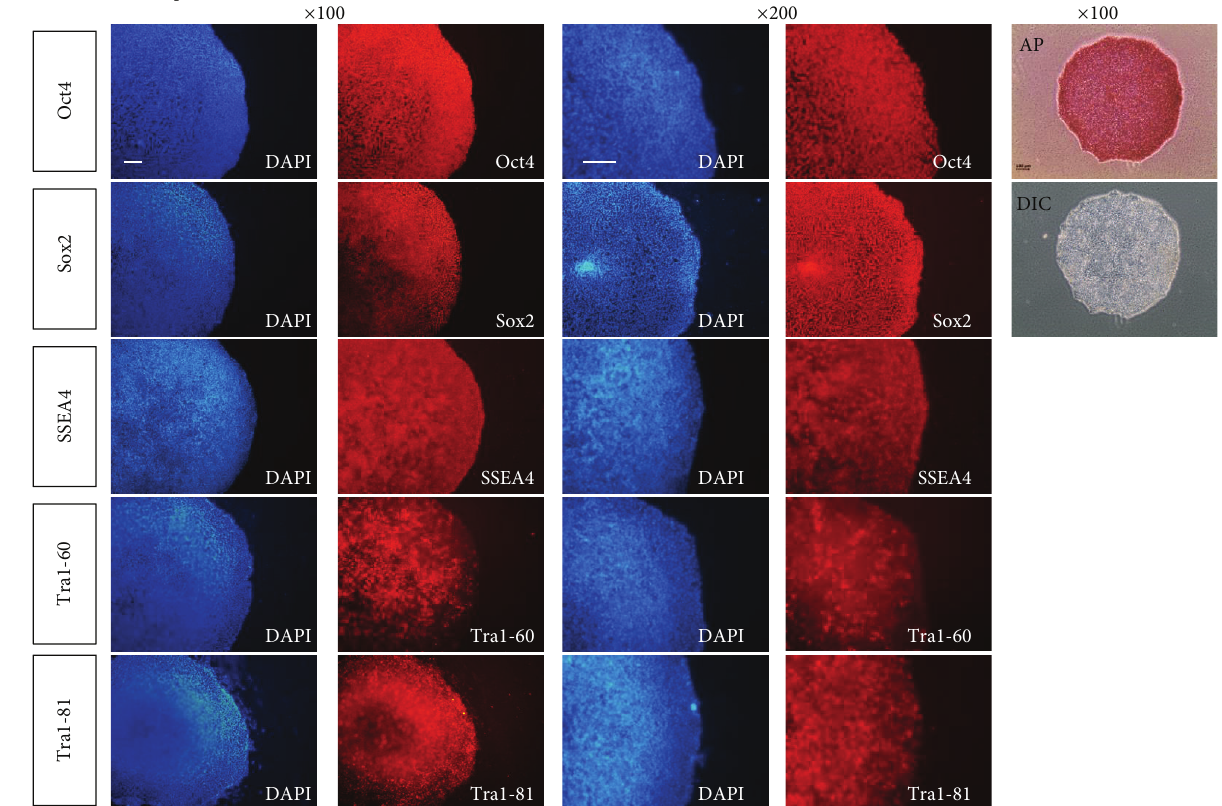
Figure 2: Immunostaining of the iPS cells for several pluripotent cell markers. The mRNA-iPSCs generated and cultured for 15 passages in our xeno-free/feeder-free hPSC system positively immunostained for the pluripotent cell markers Oct4, Sox2, SSEA4, Tra1-60, and Tra1-81. In addition, the colonies were stained with the commonly used undifferentiated cell marker alkaline phosphatase ( top right panel